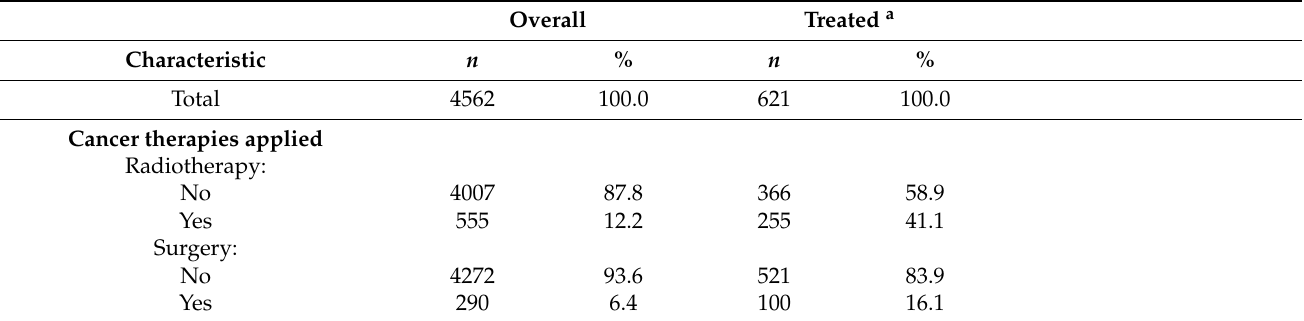
Table 2. Characteristics of patients with CUP, overall, and by receipt of anticancer pharmacotherapy. Overall Treated a